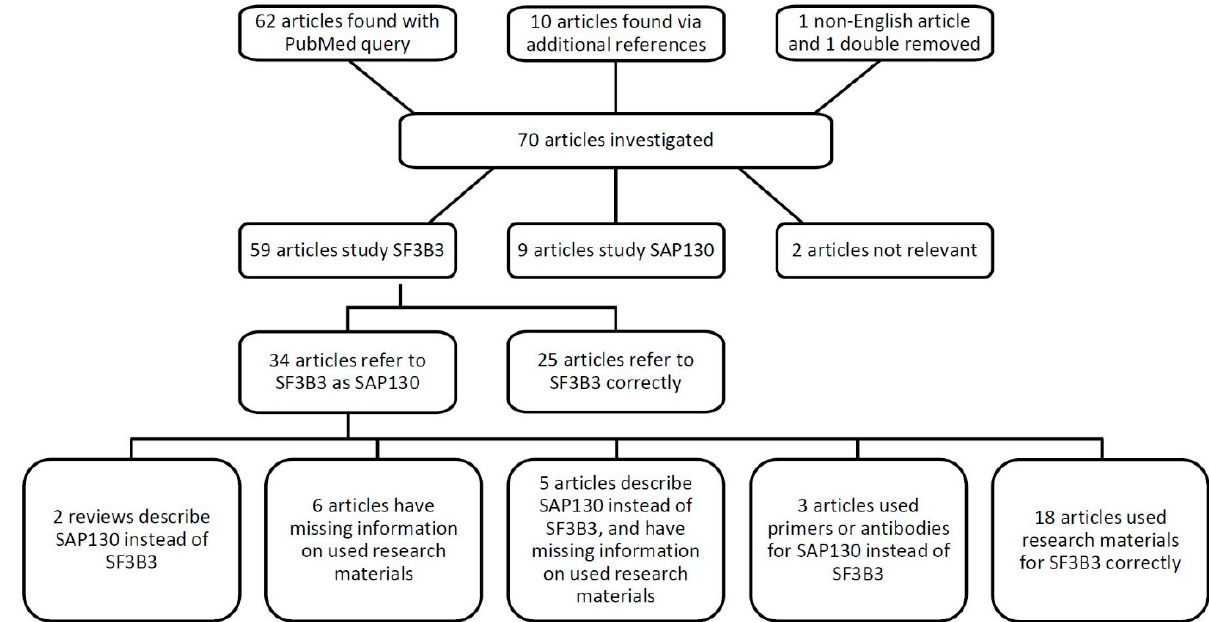
Figure 2. Schematic overview of the literature review of SF3B3 and SAP130. Table 1. List of papers whose corresponding authors were contacted. We asked eleven authors to provide missing anti- body and recombinant protein ascension numbers and/or primer sequences. Three corresponding authors were notified of the mistakes in their papers.